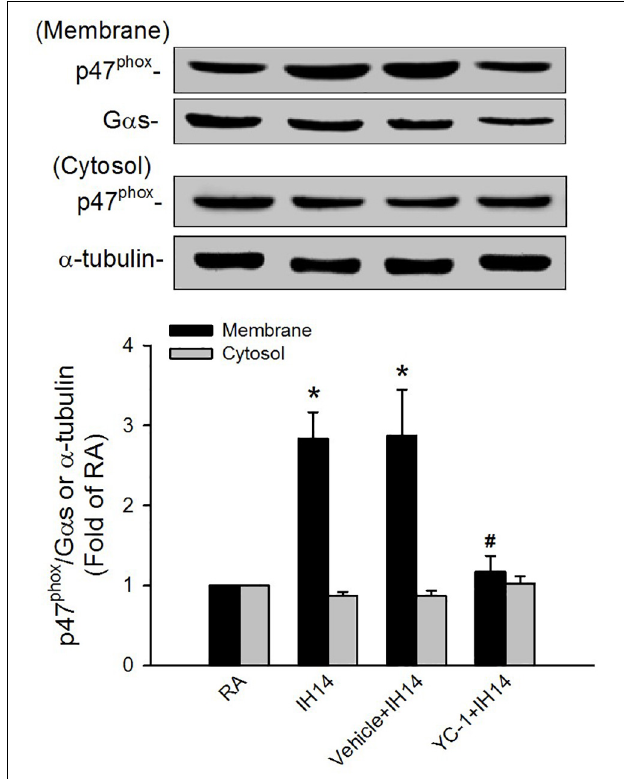
FIGURE 6 | Protein expression of p47 phox in the laryngeal tissues of rats. Four groups of rats were exposed to room air (RA) or intermittent hypoxia (IH) for 14 days with or without daily treatment with YC-1 (YC-1 + IH14) or its vehicle (Vehicle + IH14). The protein expression levels of p47 phox in the membrane and cytosolic fractions of laryngeal tissues were measured by Western blot analysis to evaluate the activation of NADPH oxidase. Data in each group are means ± SE of five rats. * p < 0.05 compared with the level of the same fraction in the RA rats; # p < 0.05 compared with the level of the same fraction in the Vehicle + IH14 rats.